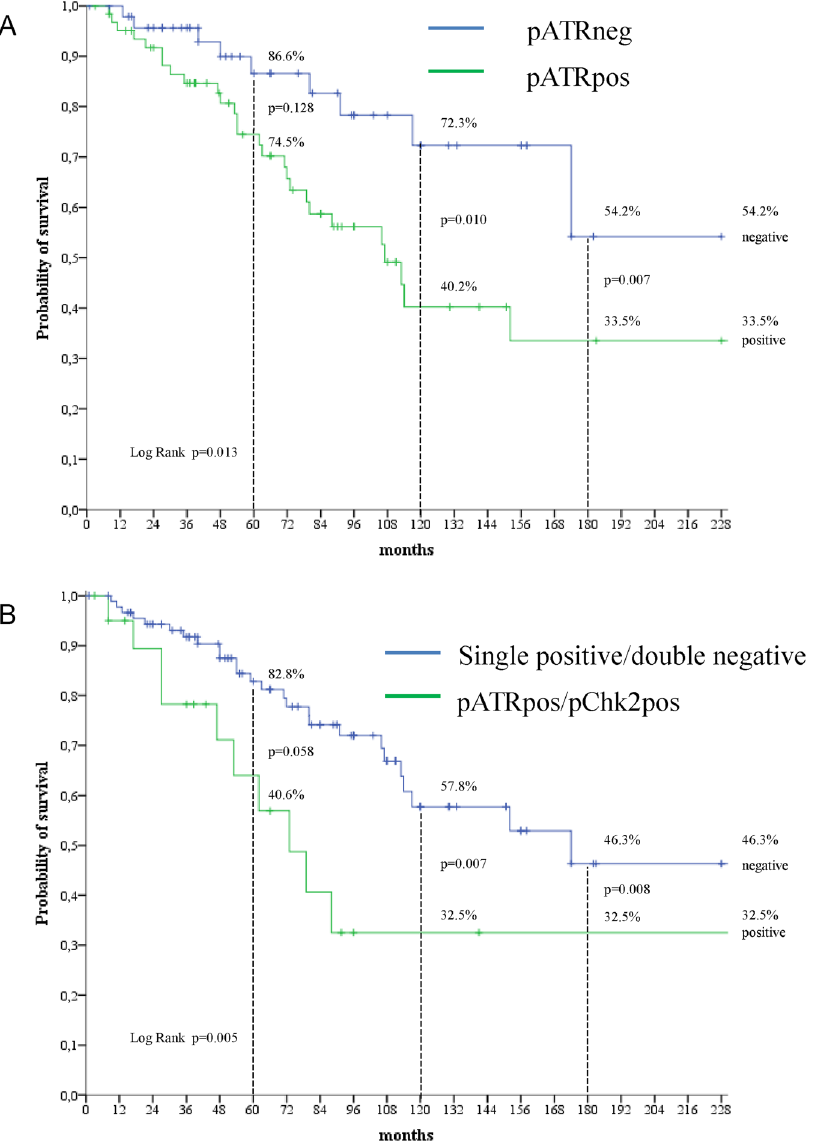
Figure 4. Kaplan-Meier survival curves comparing ( A ) pATR-positive and pATR-negative cases, and ( B ) pATR/pChk2-positive and single-positive/double-negative tumors (N =